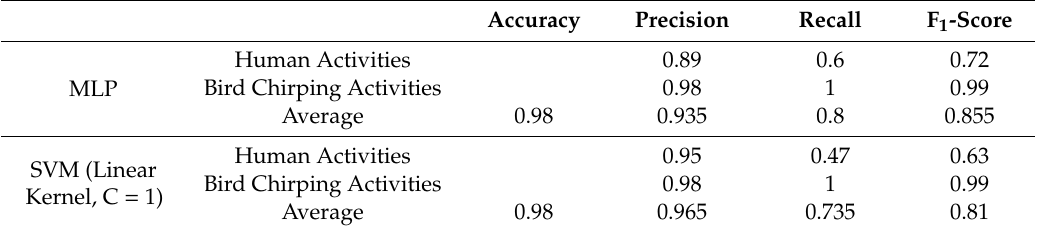
Table 2. Human activity and bird chirping activity classification results for the SVM and MLP models with the denoising technique applied.